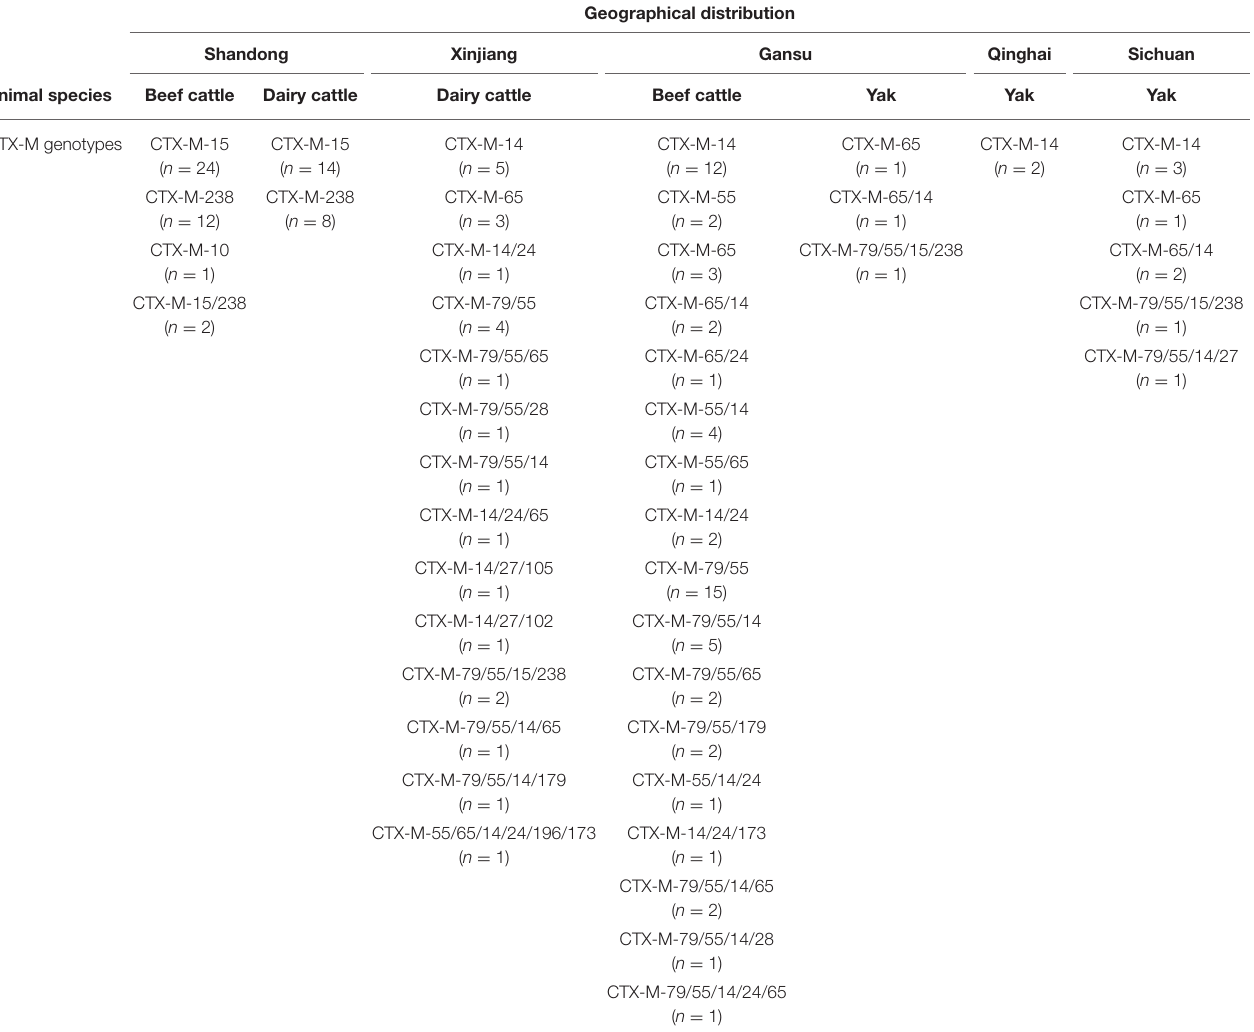
TABLE 3 | The distribution of CTX-M genotypes in different bovines and sampling